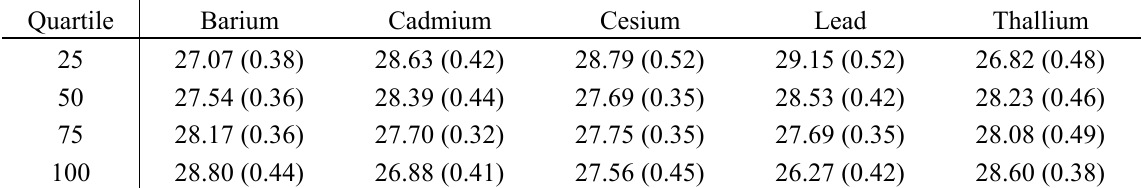
Table 13. BMI by Metal Quartiles for Adults.